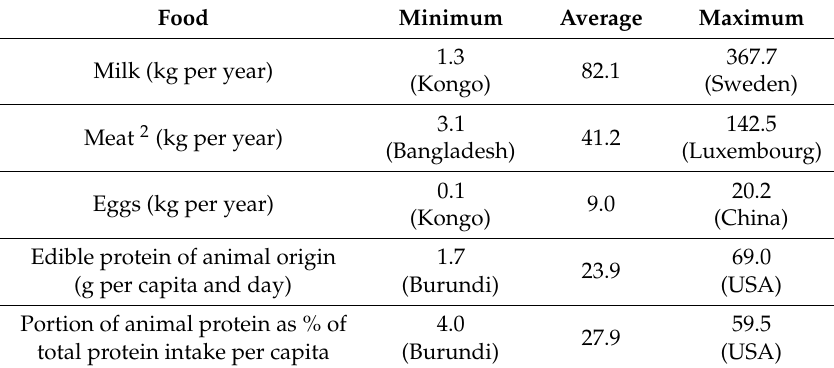
Table 1. Intake of milk, meat, and eggs as well as protein of animal origin per capita and year 1 and portion (%) of total protein intake (global minimum-values; maximum-values and averages, as well as German values for comparison; kg per capita and year: data base 2005;